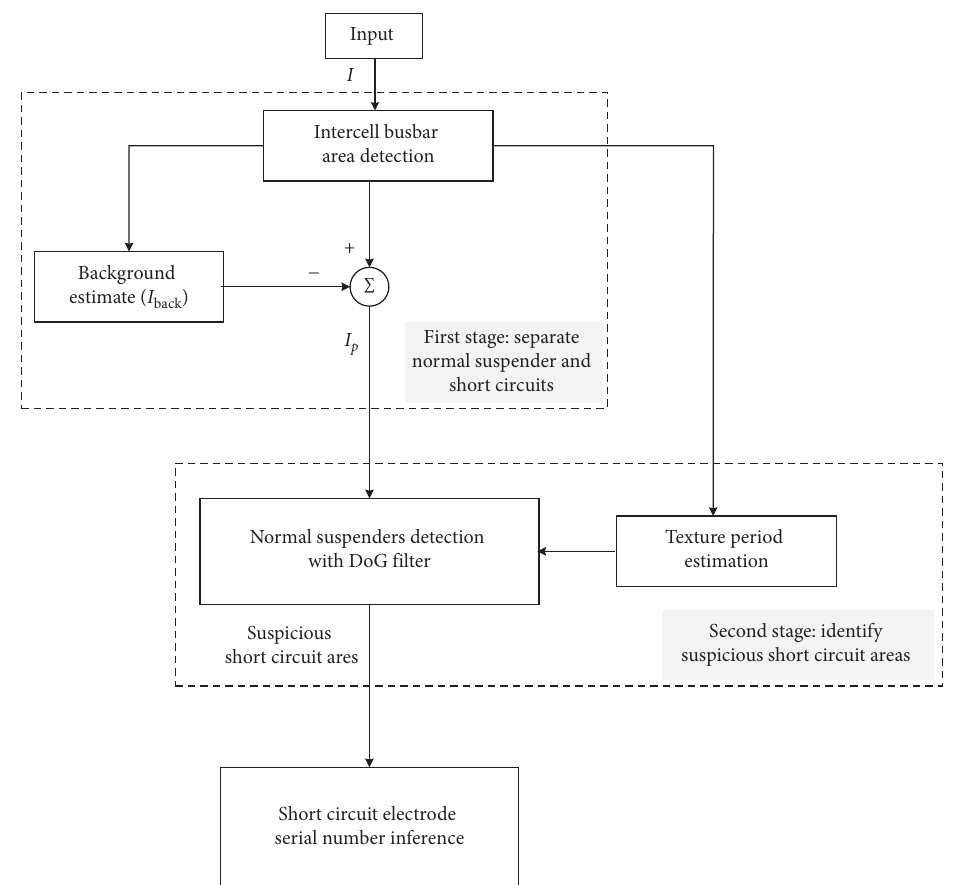
Figure 3: Two-level short circuit detection scheme